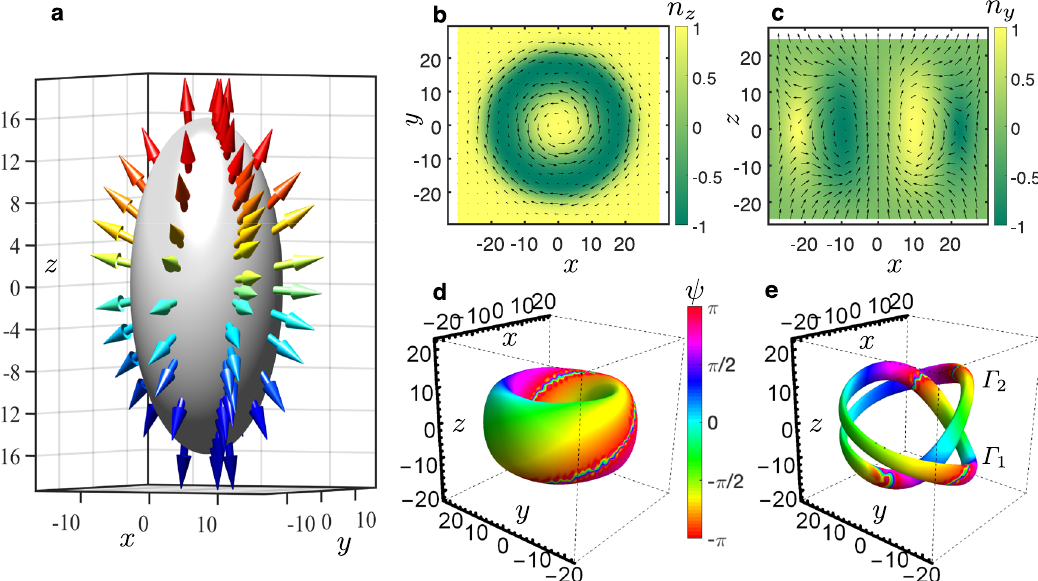
Fig. 7 Three-dimensional Skyrmion in a thin layer of Fe-langasite. a Arrows indicate the direction of Φ = ( Φ x , Φ y , Φ z ) at the Φ 0 = 0 surface (gray ellipsoid). The corresponding n -con fi guration in the xy plane passing through z = 0 (panel b ) and in the xz plane passing through y = 0 (panel c ). d False color plot of the angle ψ at the n z = − 1/2 surface. e Linking of two closed oriented paths, Γ 1,2 , formed by the constant- n lines: ffiffiffi p ffiffiffi p ¼ ð = 2 ; 0 ; (cid:2) 1 = 2 Þ T , for Γ = J = 1, λ = 0.5, K = 0, K = 0.1, H = 0 = 2 ; (cid:2) 1 = 2 Þ T , for Γ 3 n ¼ ð 0 ; 3 z 1 , and n 2 . The numerical simulation was done for J ⊥ 1 2 ð z Þ ¼ 0 : 26 (cid:3) exp ð(cid:2) ð z 0 (cid:2)j z jÞ Þ , where z = 25 is half-width of the fi and an additional surface anisotropy with K s 0 2 3 : 0